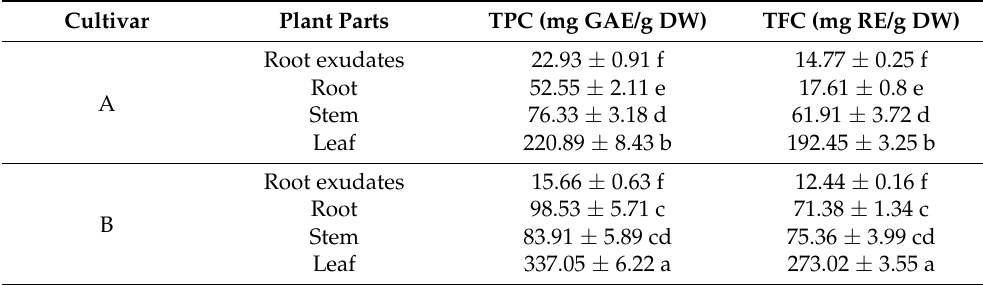
Table 4. Total phenolic and total flavonoid contents in sweet sorghum extracts.